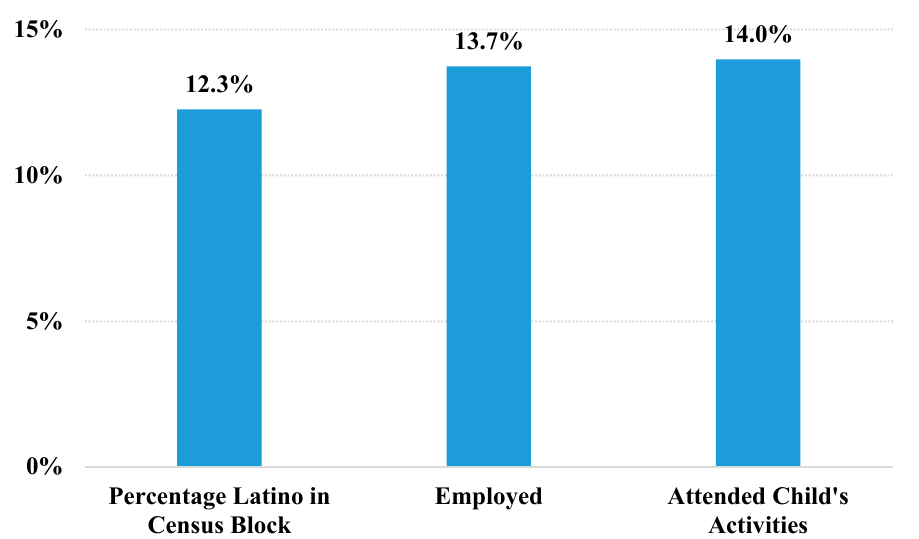
Figure 2. The Probability of Having Engaged in Social Capital Accumulation.